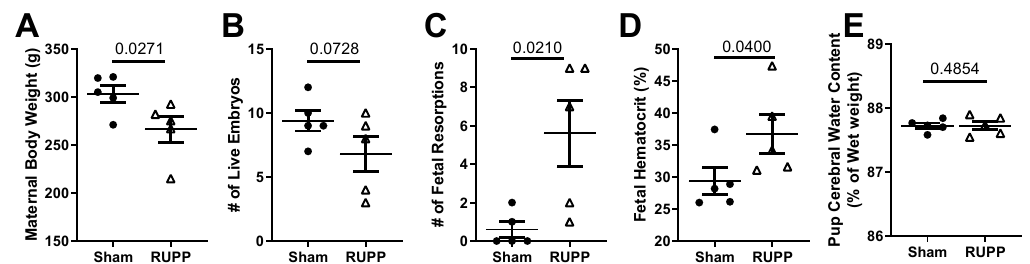
Figure 1. General characteristics of dams and fetuses subjected to placental ischemia. Dams had ( A ) reduced body weight, ( B ) reduced numbers of live fetuses, and ( C ) increased fetal demise at gestational day (GD) 19 compared to the sham controls. Fetuses subjected to placental ischemia had ( D ) increased hematocrits and ( E ) no change in brain water content. Values for individual rats ( n = 5 dams per group) are shown along with the Mean ± SEM. Fetal hematocrit and pup brain water content represent the mean of 1–2 pups / dam ( n = 5 dams). Differences between groups were analyzed using an unpaired T-test.